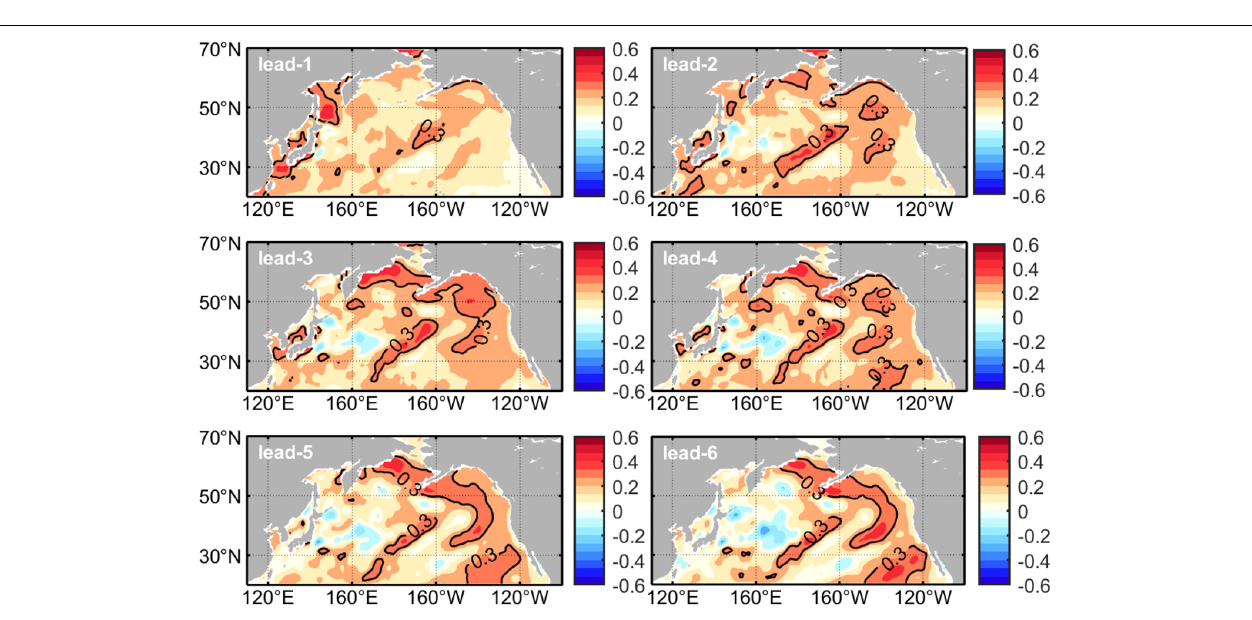
FIGURE 5 | The differences of ACC between the EAKF and Projection-OI hindcasts in each lead month averaged for 1993–2017. Only the line of 0.3 contour is